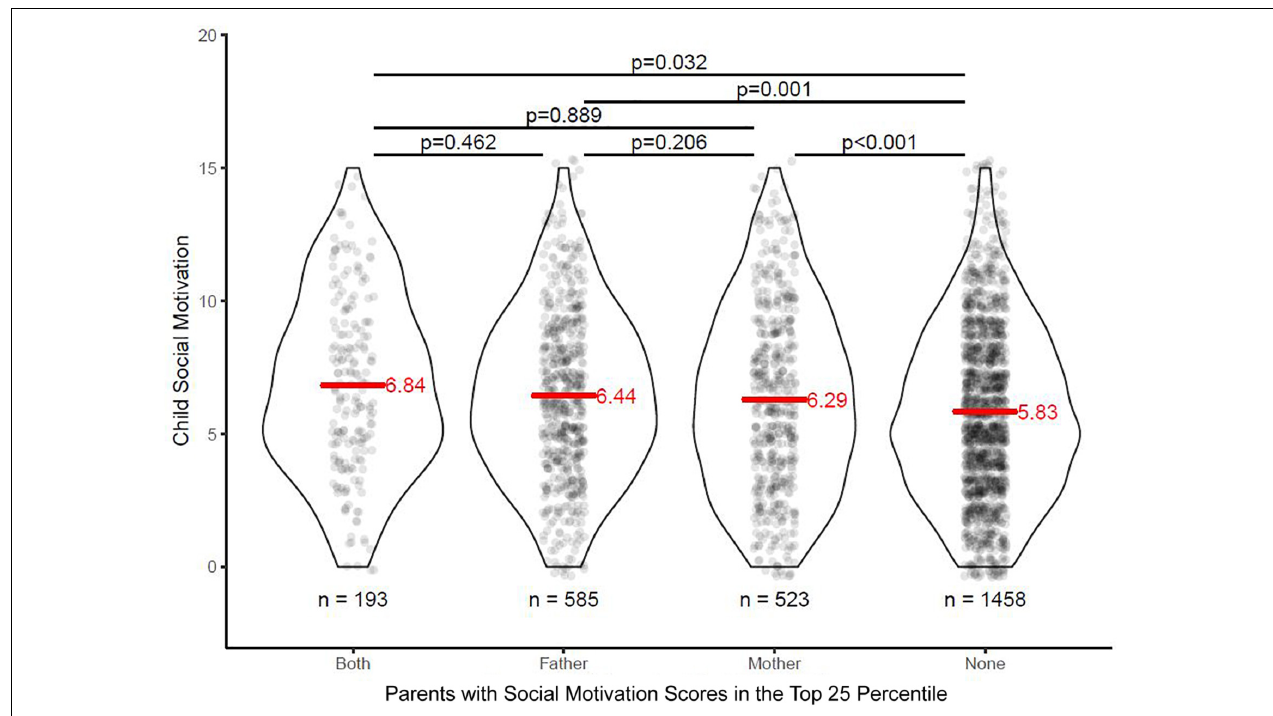
FIGURE 1 | Children’s social motivation scores as a function of parental social motivation status. Both, both mother and father had SM scores in the top 25 percentile of the respective score distribution; neither, neither mother or father had SM scores in the top 25 percentile of the respective score distribution; SM, social motivation.